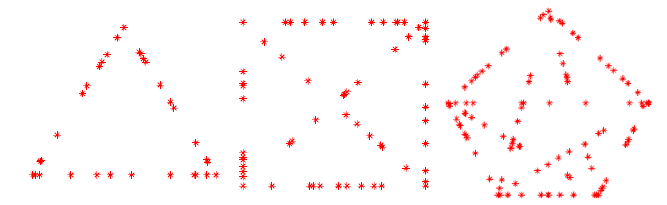
Figure 4. Edges and diagonals of a face are sampled with a random number generator which is initialized by the texture coordinates of the vertices of the edge or diagonal.